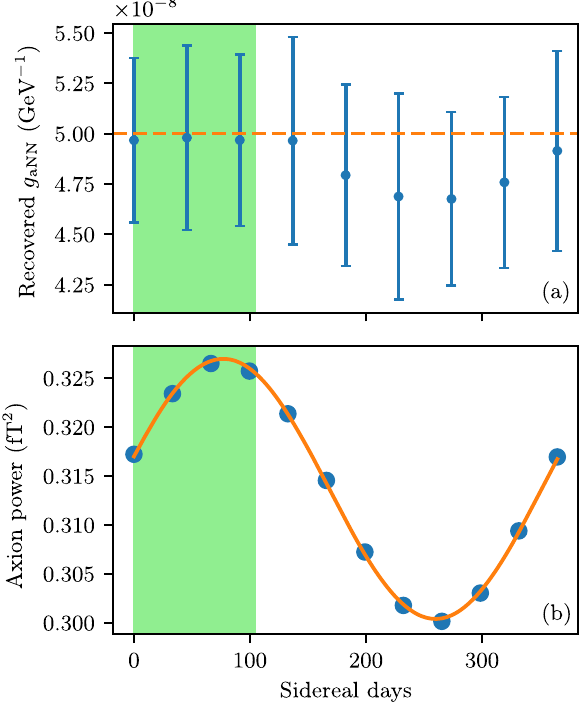
FIG. 7. (a) Expected annual modulation of the recovered best- fit g for a 6-Hz axion. This modulation of the best-fit g aNN aNN stems from deviation of both the magnitude and direction of v E from h v , where v is Earth ’ s instantaneous velocity relative to E i E is its annual average that we use in the Galactic Center, and h v E i our analysis. Because these deviations do not necessarily occur symmetrically, the annual modulation of the best-fit g is not aNN always symmetric. This modulation of the recovered best-fit g aNN should be contrasted with the expected annual modulation of the axion ’ s power that we show in (b), where blue dots give the expected axion power over 12 months, and the orange line is a sinusoidal fit to the blue points. The dashed orange line in (a) indicates the injected g , which is larger than any of the aNN recovered best-fit g in Fig. 8. The green shaded window aNN indicates the time span of the experiment, which started data collection on 3022.63 sidereal days since J2000.0. As the results in (a) show, no significant deviation of the recovered g is aNN expected over the time span of our experiment due to our use of h v e i rather than the instantaneous v E in our analysis. Vertical lines in (a) give the 1 σ containment interval for the best-fit g from aNN 100 Monte Carlo datasets. The simulated data have a white-noise ffiffiffiffiffiffi p background of 1 . 6 fT = Hz , which is comparable to the experi- ment ’ s noise